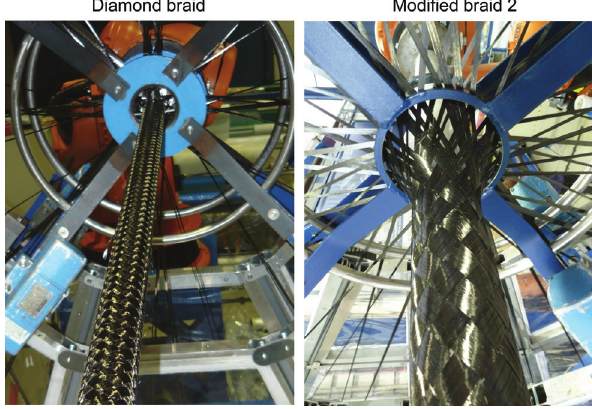
Figure 14 Two braiding placement processes with different textile patterns.